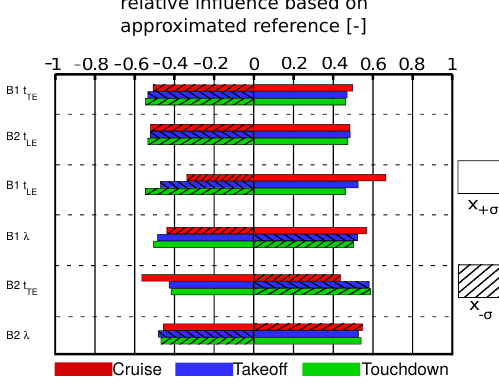
Figure 8. Sensitivities of ζ of blade 1 for all three operating